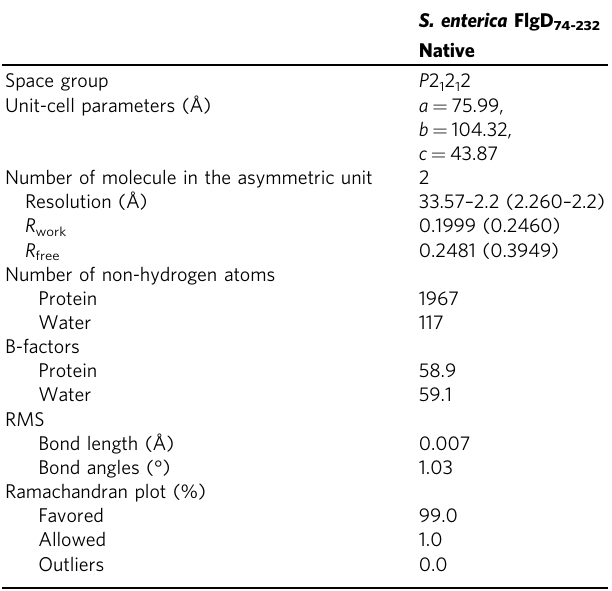
Table 2 Summary of the re fi nement statistics for the S. enterica FlgD 74-232 fragment.